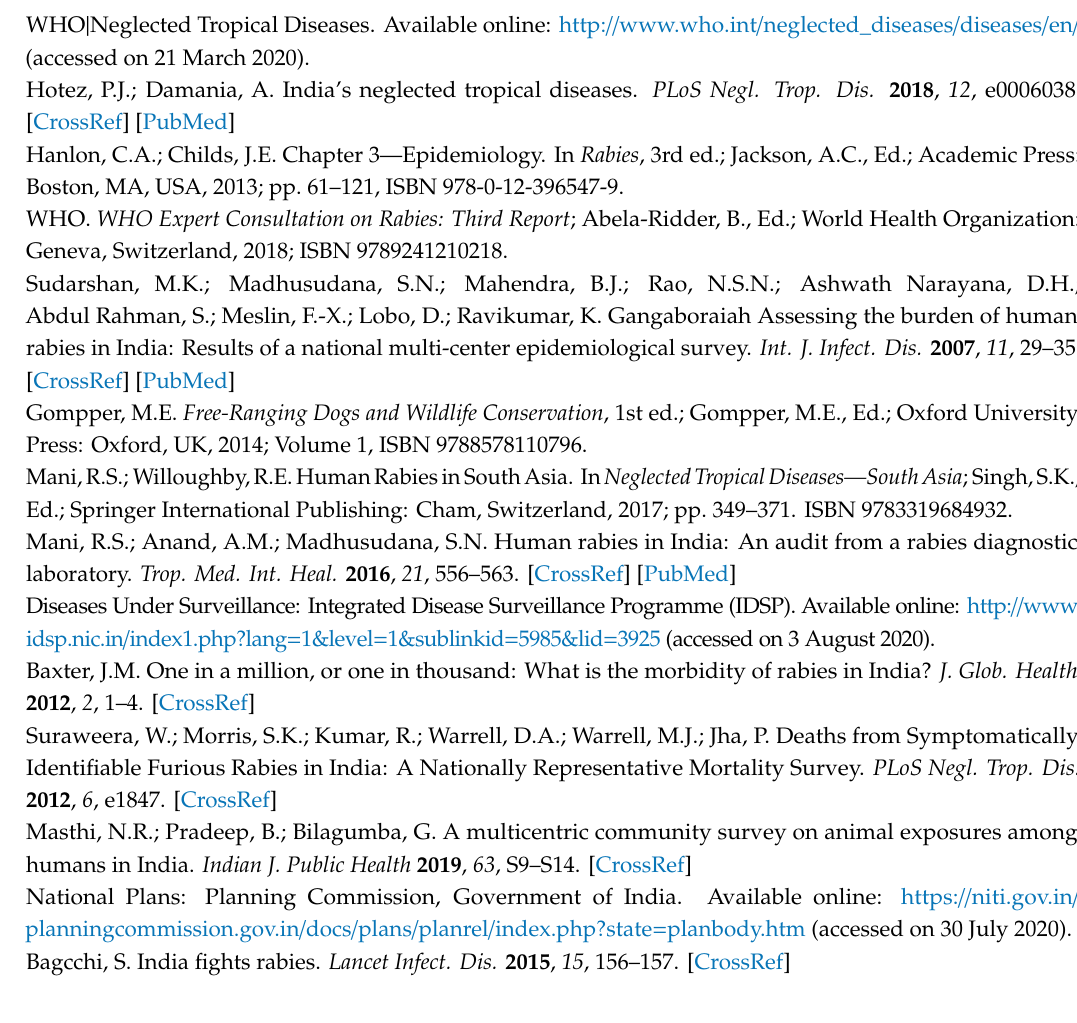
Table S1. Annual rabies incidence in all animal species between 1887–88 and 1950–51 (denoted 1888 and 1951, respectively) in all British provinces in India and the princely state of Manipur. Statistics were compiled from annual reports of the Civil Veterinary Department of the colonial British Government of India, available at https: // digital.nls.uk / indiapapers /